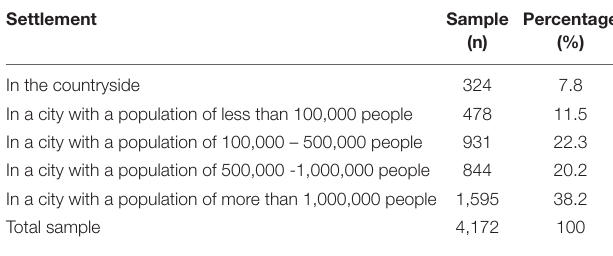
TABLE 1 | Sociodemographic characteristics of the study